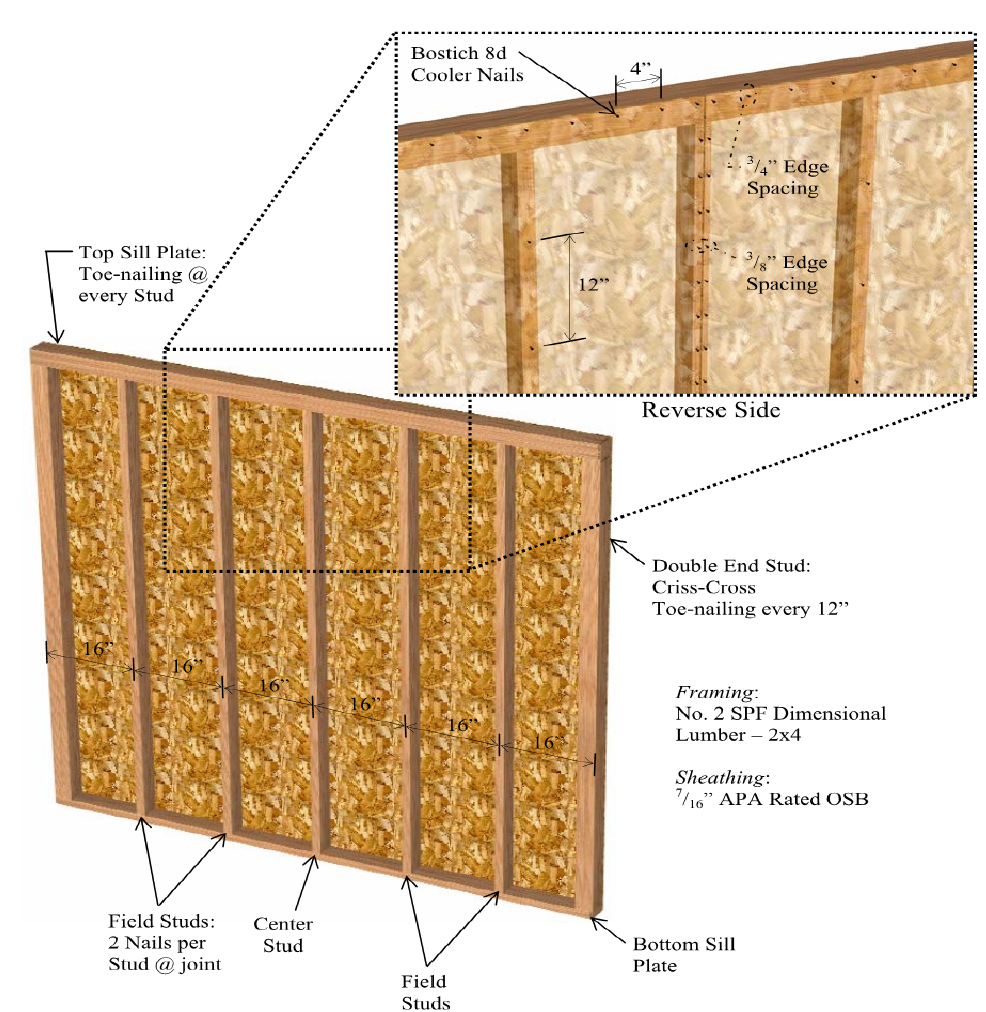
Figure 1. OSBwall (oriented strand board)